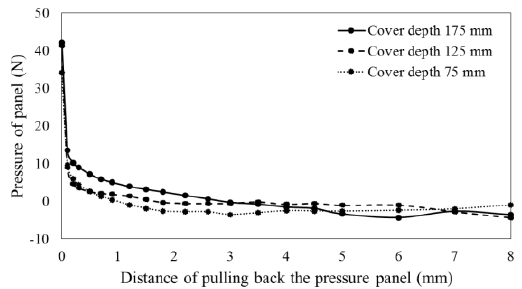
Figure 7. Pressure of panel according to distance during Stage 1.